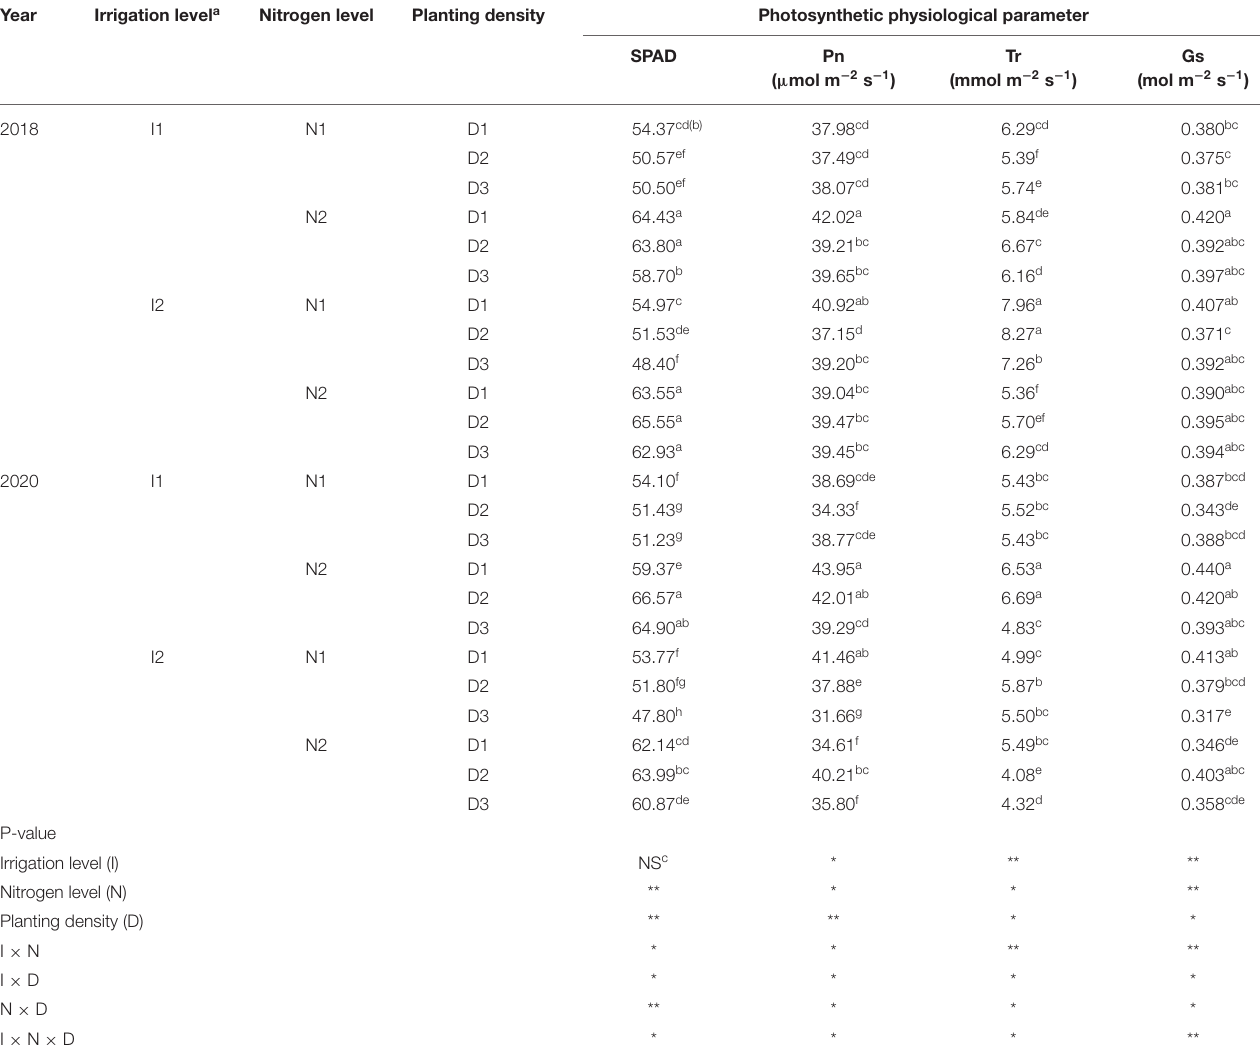
TABLE 2 | SPAD, net photosynthetic rate (Pn), transpiration rate (Tr), and stomatal conductance (Gs) of maize at silking stage as affected by irrigation and nitrogen levels and planting density in 2018 and 2020 at arid irrigated regions.